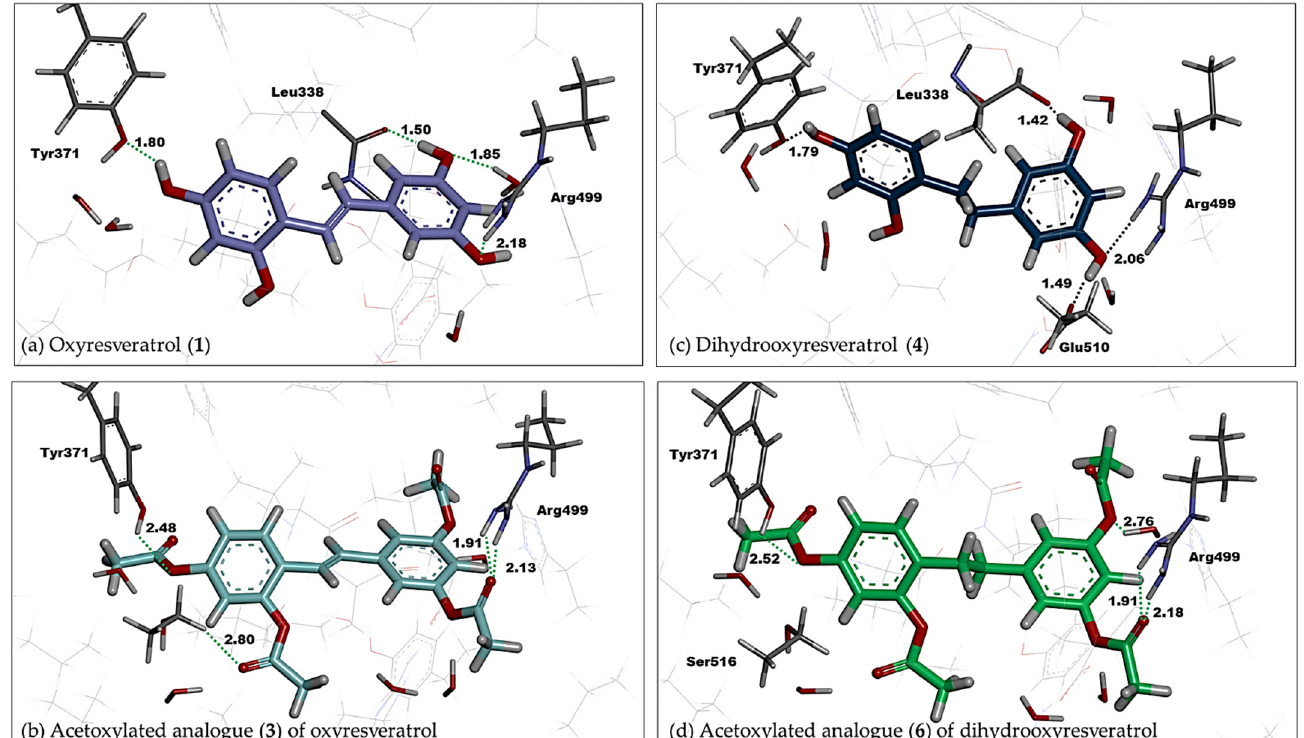
Figure 5. Hydrogen bonding interactions of the lowest-QM-energy poses (stick representation) of ( a ) oxyresveratrol ( 1 ), ( b ) acetoxylated analogue ( 3 ) of oxyresveratrol, ( c ) dihydrooxyresveratrol ( 4 ) and ( d ) acetoxylated analogue ( 6 ) of dihydrooxyresveratrol in the active site of COX-2.